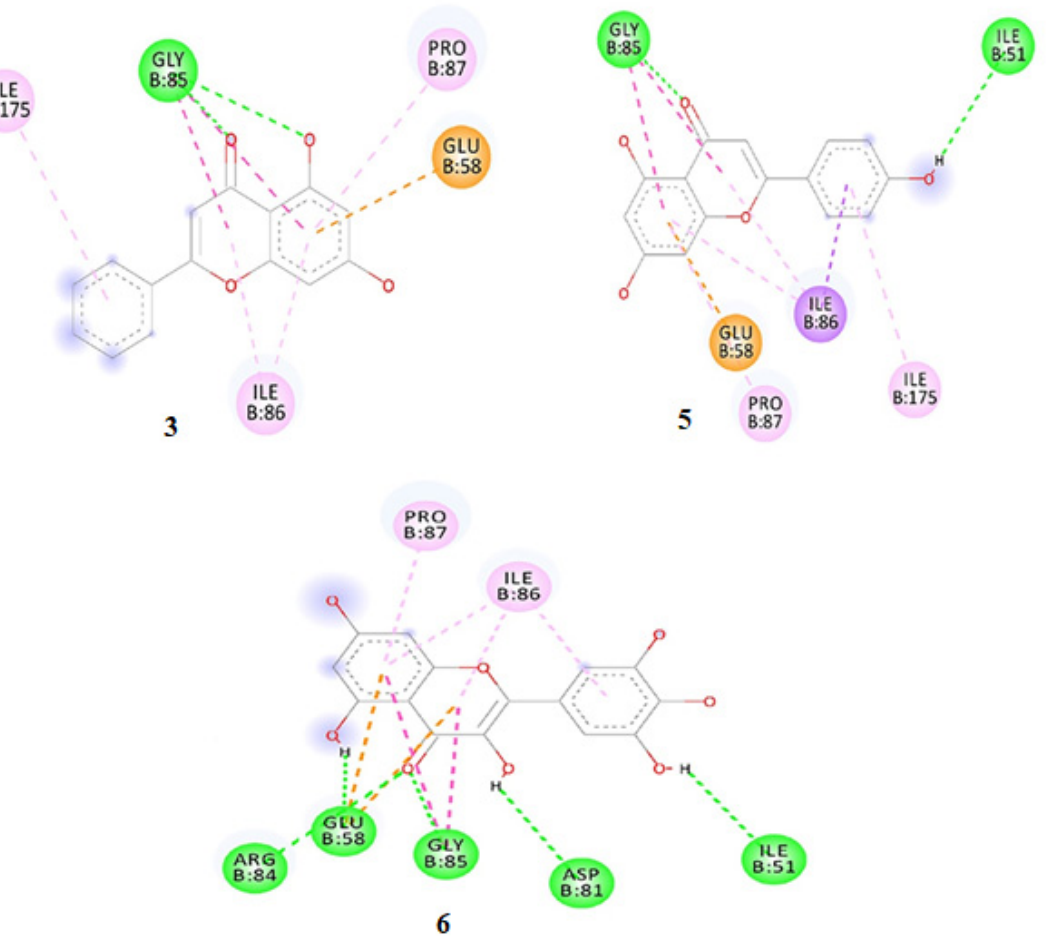
Figure 6. Receptor–ligand interplay of compounds such as 3 , 5 , and 6 with receptor 5D6P (Gyrase B of S. aureus ).